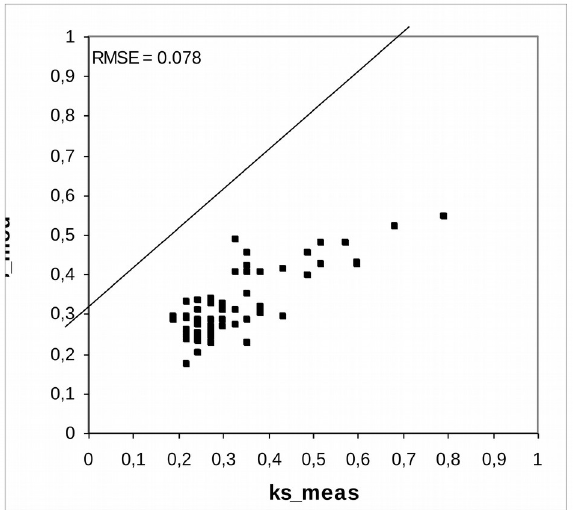
Figure 7. Modeled versus measured ks values